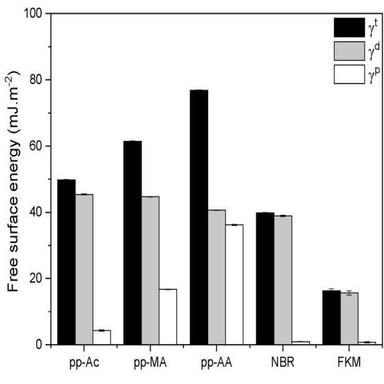
Surface free energy of pp-Ac, pp-AA, pp-MA, NBR and FKM.